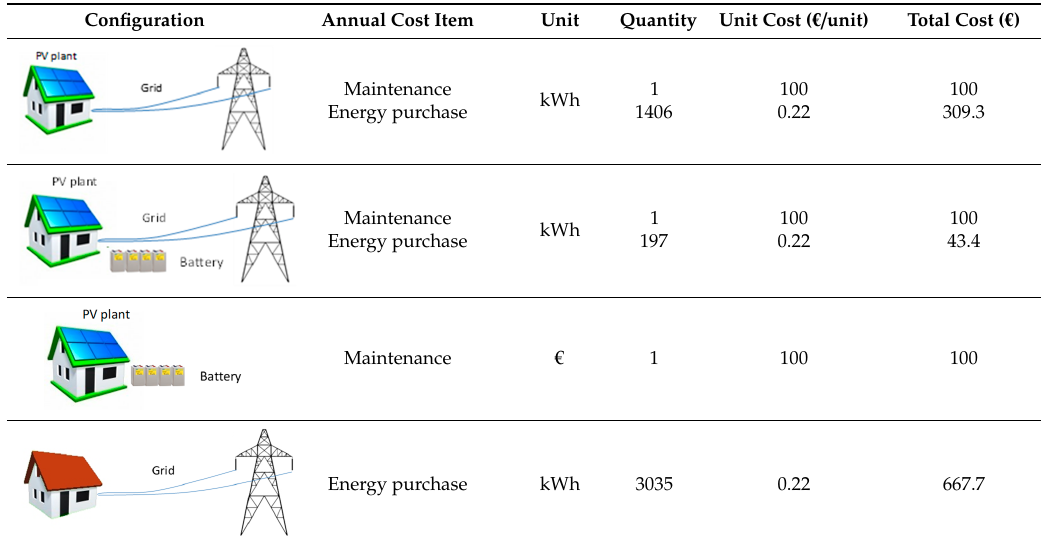
Table 5. Annual benefits.